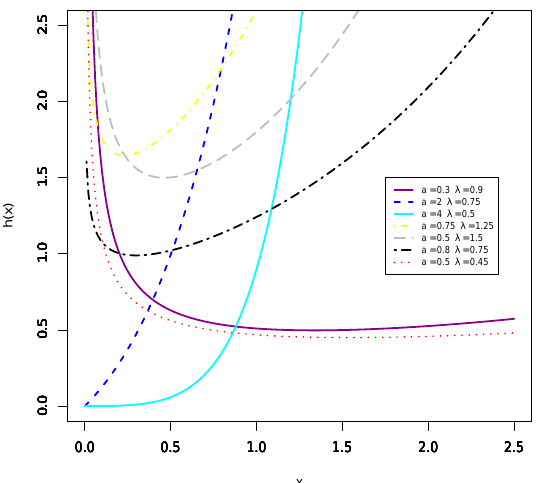
Figure 2. Plots of the MKiEx HR function with λ = 1 and different values of a .